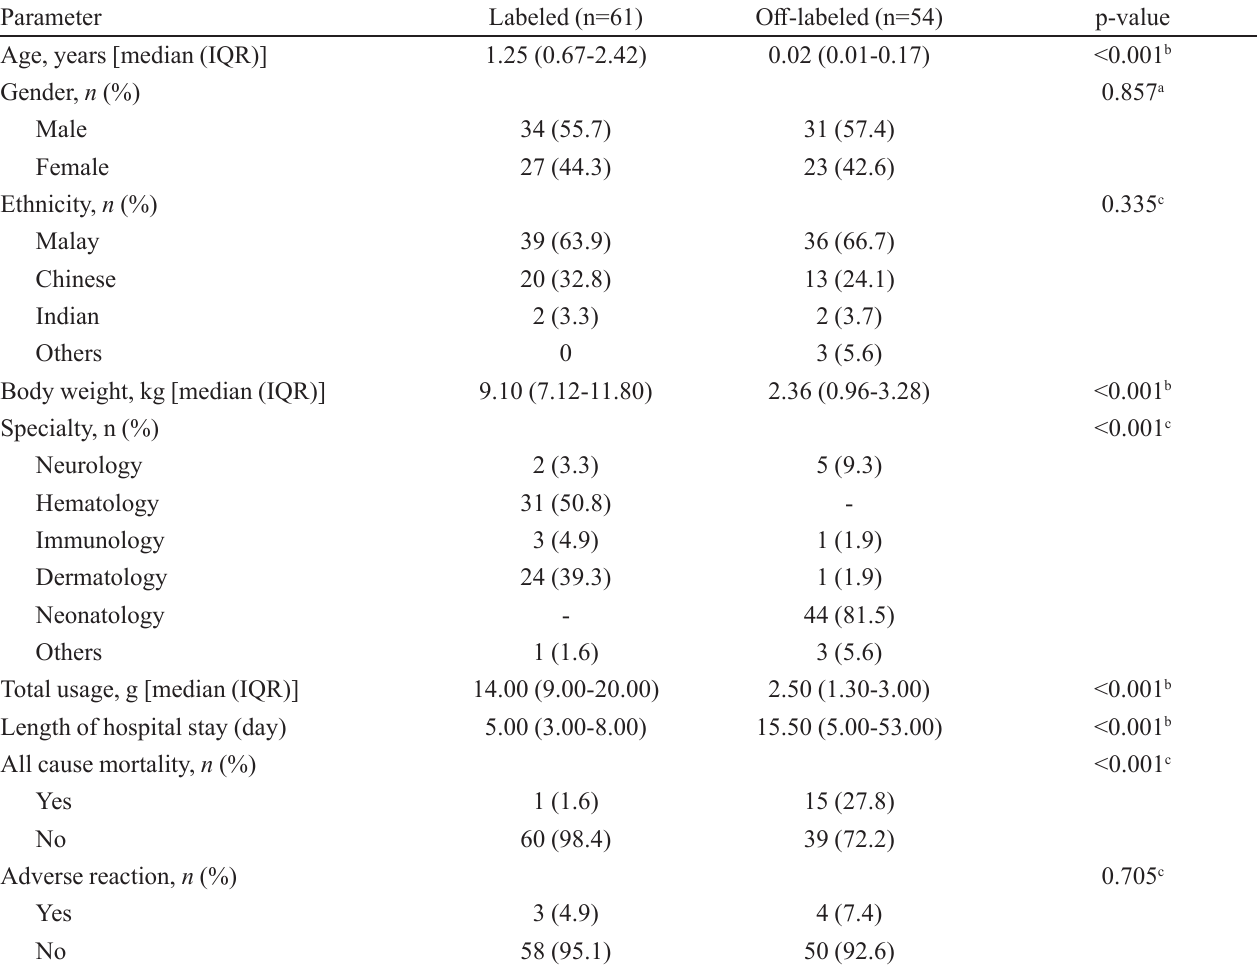
TABLE III – Association between demographics and clinical data with labeled and off-labeled indications